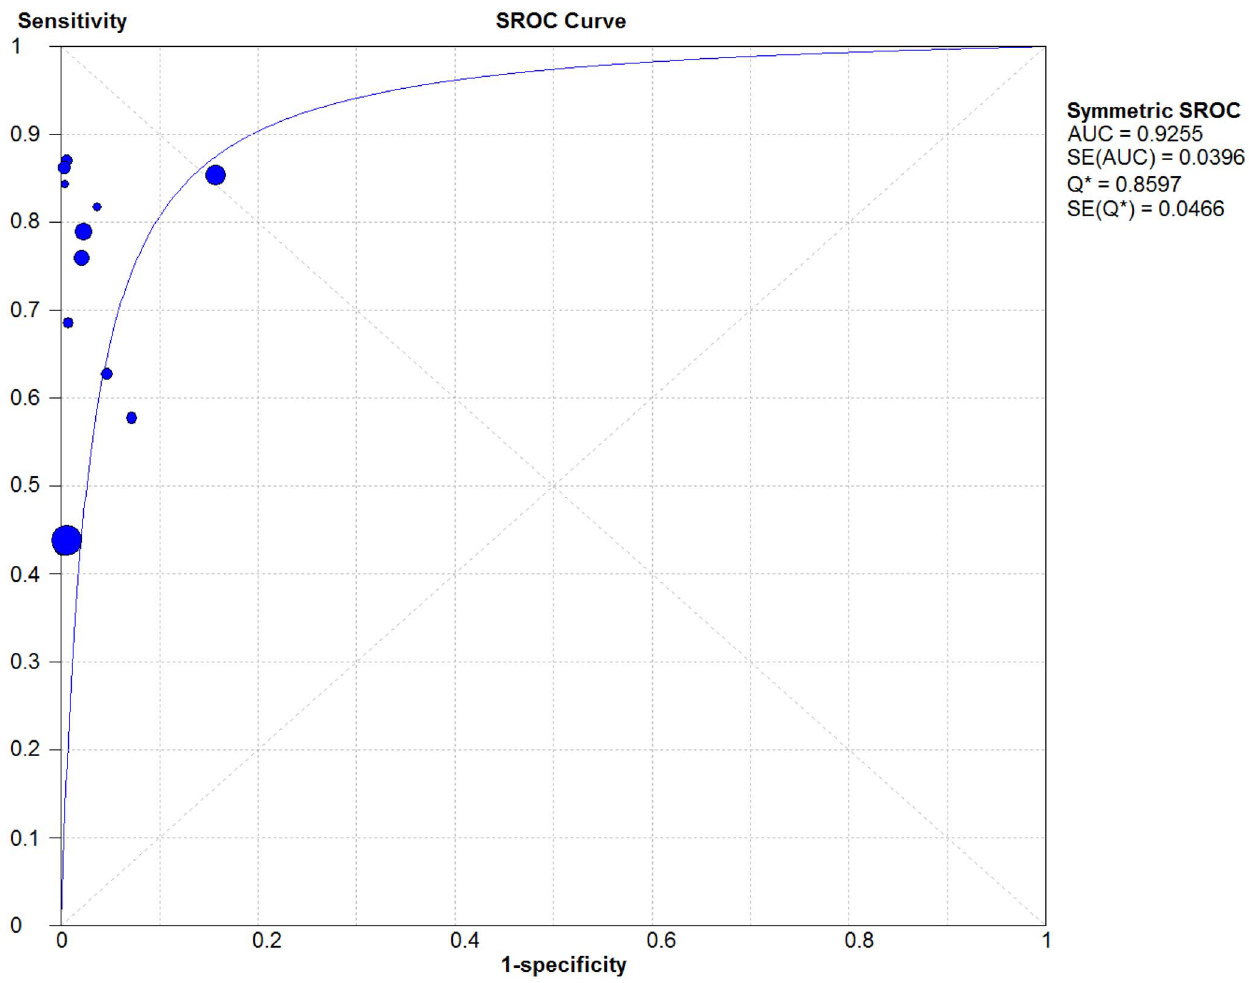
Figure 3. Receiver Operating Characteristic Curve Describing the Diagnostic Performance of Heart Failure Codes in Administrative Databases. AUC=Area Under the Curve; SROC=Summary Receiver Operating Characteristic; SE=standard error.